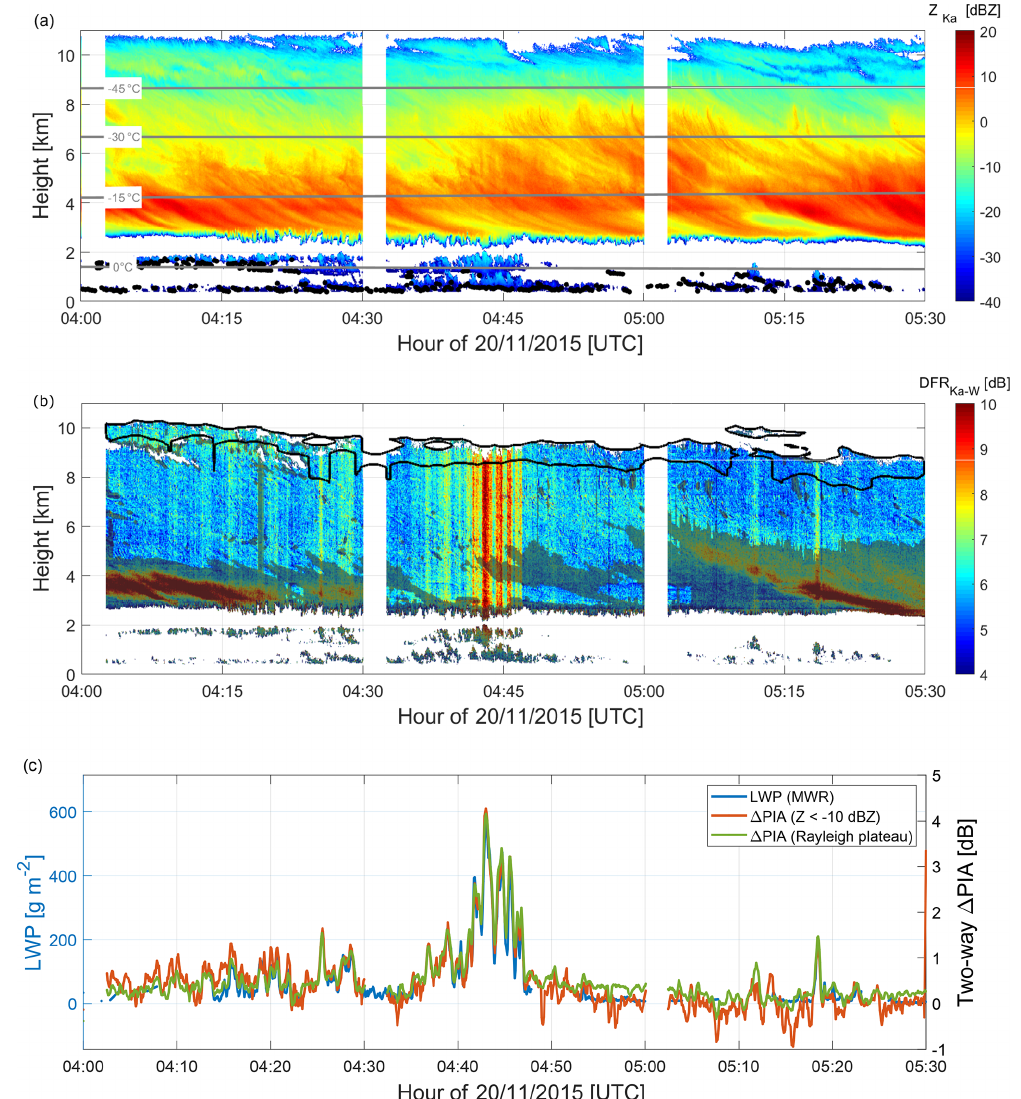
Figure 5. Zoom into the period of low-level liquid clouds from the case study shown in Fig. 4 (earliest square). Time–height (UTC–km) plots of (a) K a reflectivity with liquid cloud base detected by the co-located ceilometer as black points and (b) K a –W DFR. Parts that have been detected by the filtering criteria to contain non-Rayleigh scattering particles are highlighted by the gray shading. (c) Time series of the K a –W DFR at cloud top, i.e., the two-way (cid:49) PIA derived with the Z e -threshold approach and with the Rayleigh plateau method (scale on the right y axis) overlaid by the LWP measured by the MWR (scale on the left y axis). Note that the scaling of the (cid:49) PIA axis was adjusted to match LWP at 0°C, i.e., assuming a two-way liquid water attenuation of 7dBg − 1 m 2 . The gray lines show the − 45, − 30, − 15, and 0°C = − 10dBZ contour in (b) isotherms in (a) , and the black line shows the uppermost Z K a